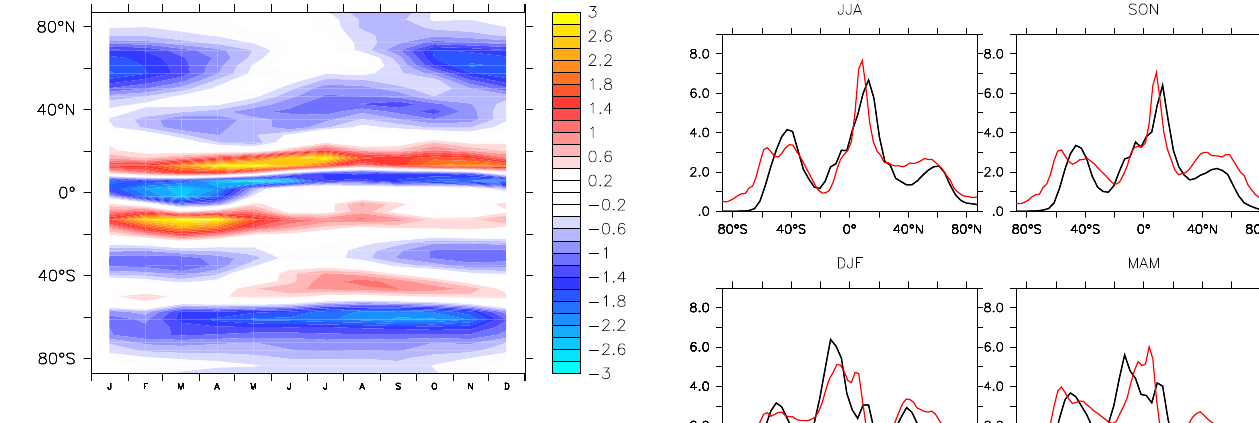
Fig. 14. Zonally averaged difference in the precipitation rate (in mmday − 1 ) between climatologies derived from simulation